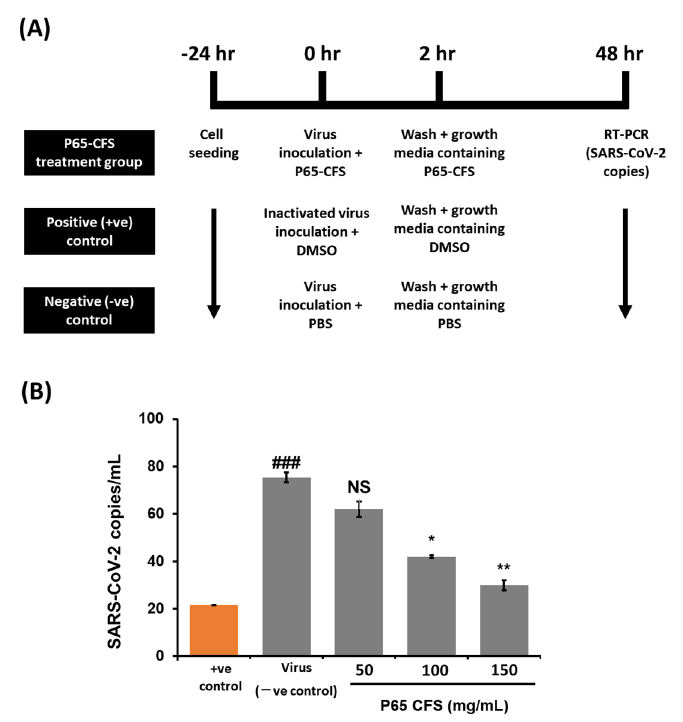
Figure 2. SARS-CoV-2 infection assay and the inhibitive effect of a cell-free supernatant of L. sakei Probio65 (P65-CFS) on viral replication. ( A ) Schematic of the SARS-CoV-2 infection assay and treatment groups. ( B ) Viral replication of SARS-CoV-2 in HEK293 quantified by RT-PCR. All wells were treated with an active virus, except for the positive controls, where the viruses were heat-inactivated at 95 ◦ C for 15 min prior to their addition to cells. Cells were treated with P65-CFS (50–150 mg/mL) during the infection and after the infection; meanwhile, the positive control (+ve control) samples were treated in the same manner with the same volume of DMSO and the negative control ( − ve control) samples were treated with PBS. Analysis of each sample were performed in triplicate, and data are represented as the means ± SD of three independent experiments. The results are presented as average values with the standard error of means (error bars). Independent t -tests were performed to compare the data with controls, where (###) represents p < 0.001, as compared to the positive control; (**) represents p < 0.01, and (*) represents p < 0.05, as compared to the virus (infected negative control).